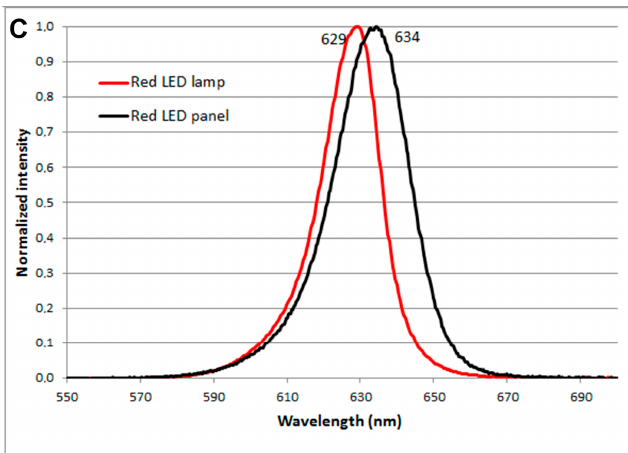
Figure 3. ( A – C ) Spectra of the five different light sources. Table 1. Fluence rate (PpIX-weighted full spectrum), fluence (PpIX light doses), intensity of visible light (lux) and how many lux are needed for a complete photobleaching in two hours using the five different light sources. All numbers in the table are for the distance of 1 meter except for the last column (see distances for the last column in Table 2). The visible light intensity is shown for simplicity because it is inexpensive and very easy to measure without prior knowledge.